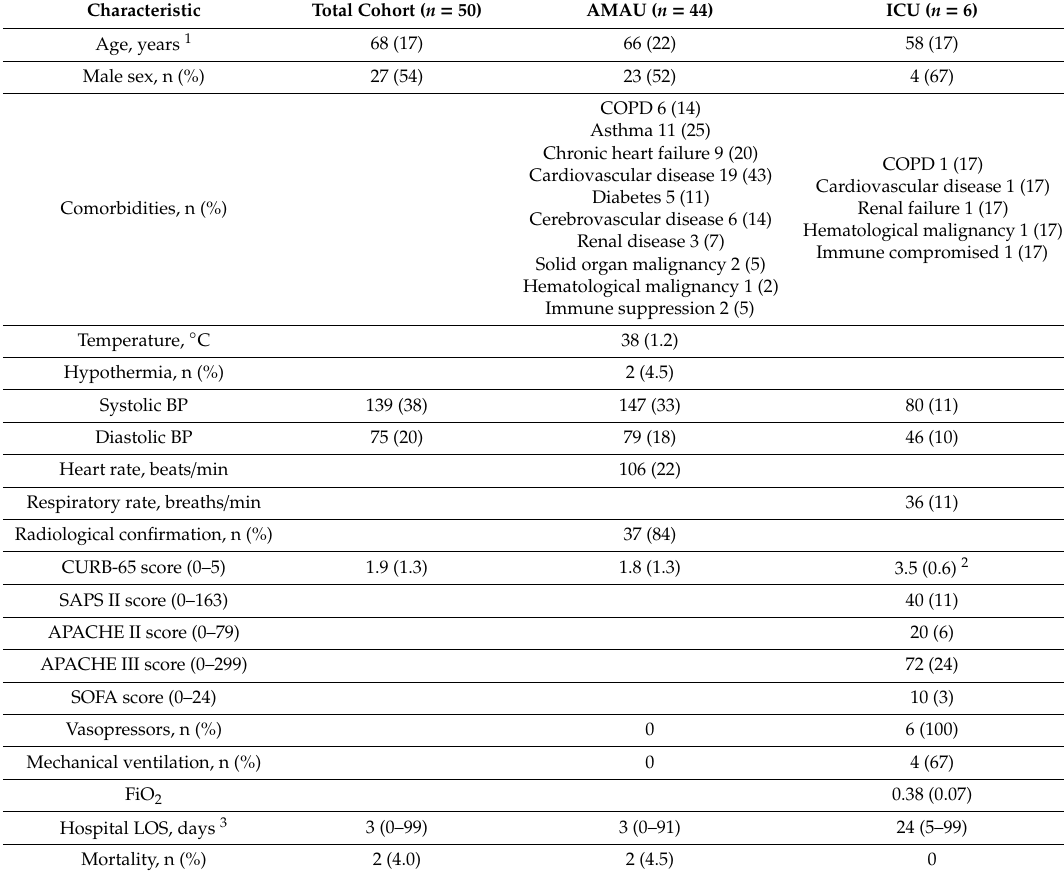
Table 1. Participant baseline